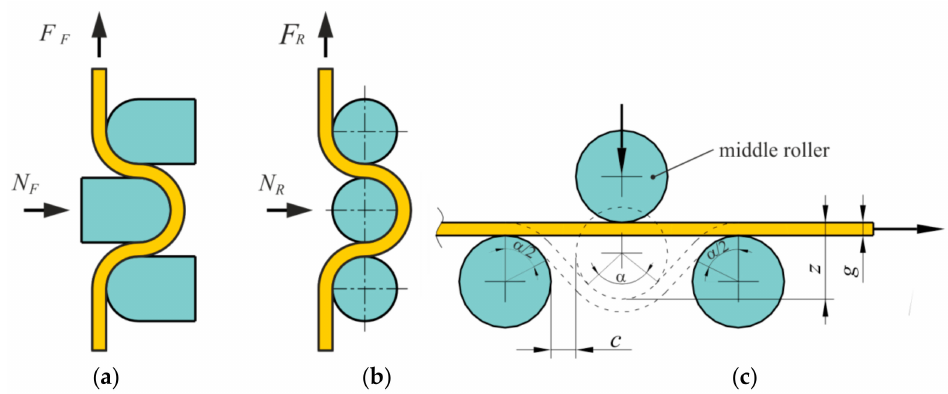
Figure 23. The concept of determining frictional resistance: ( a ) fixed rollers, ( b ) rotatable rollers, ( c ) geometrical parameters of draw